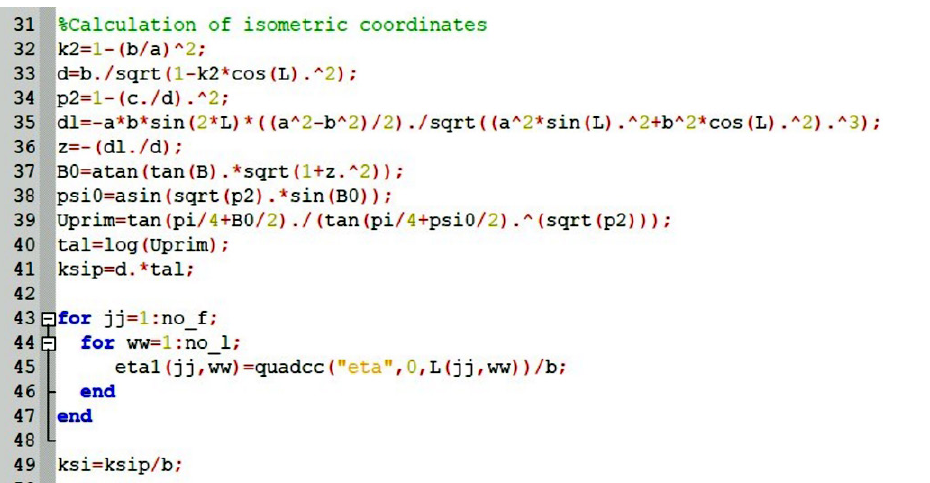
Fig. 4. Calculating the conformal coordinates